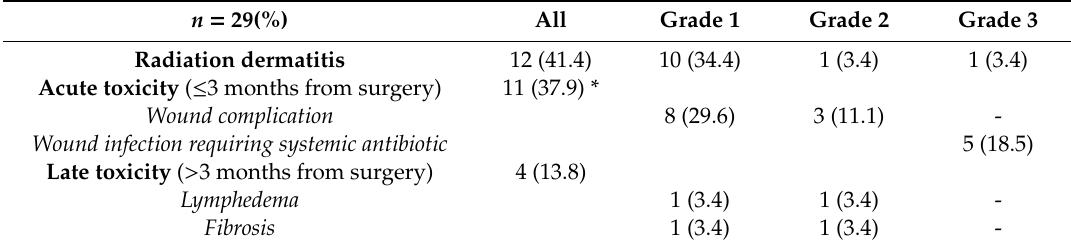
Table 2. Treatment toxicity, according to CTCAE (National Cancer Institute Common Terminology Criteria for Adverse Events) version